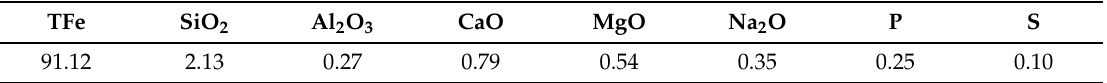
Table 6. Chemical composition of metallic iron powder/%.